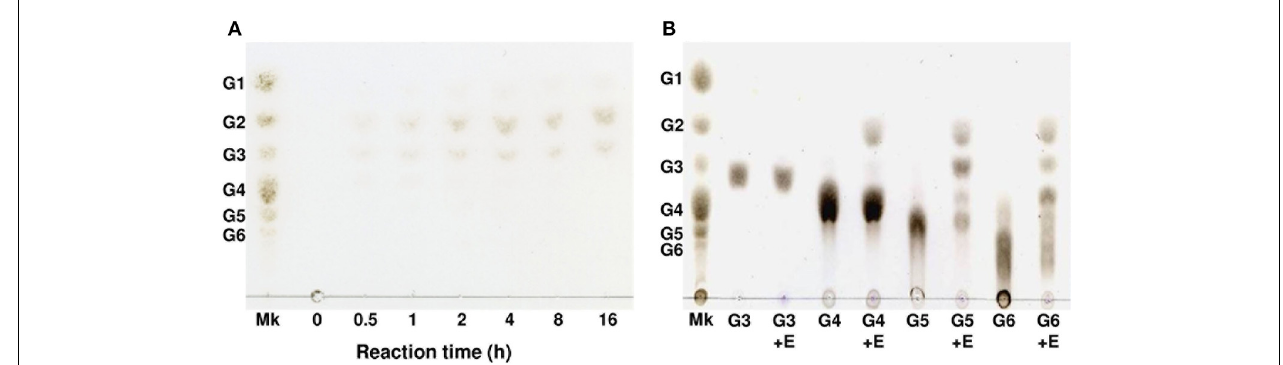
FIGURE 4 | Thin-layer chromatography of degradation products of phosphoric acid-swollen cellulose and cello-oligosaccharides produced by AkEG21. (A) The reaction mixture of 1.0mL containing 2.5mg of phosphoric acid-swollen cellulose, 10mM sodium phosphate (pH 6.0), and 7 U of AkEG21 was incubated at 37 ◦ C for up to 16h. The supernatant of the